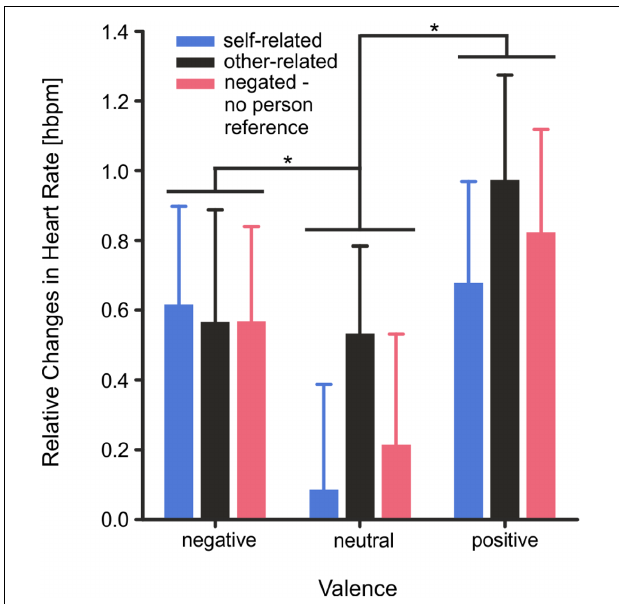
FIGURE 6 | Heart rate activity as measured by 3-Lead ECG and depicted as mean changes during the stimulus interval from 0 to 4000 ms. Error bars depict SEM. Changes are illustrated as relative changes from baseline for all stimulus categories. However, as described in detail in the text, mean heart rate was significantly modulated by the factor valence and not by the factor reference and the interaction of the factors valence × reference was not significant. ∗ p < 0.05, FDR